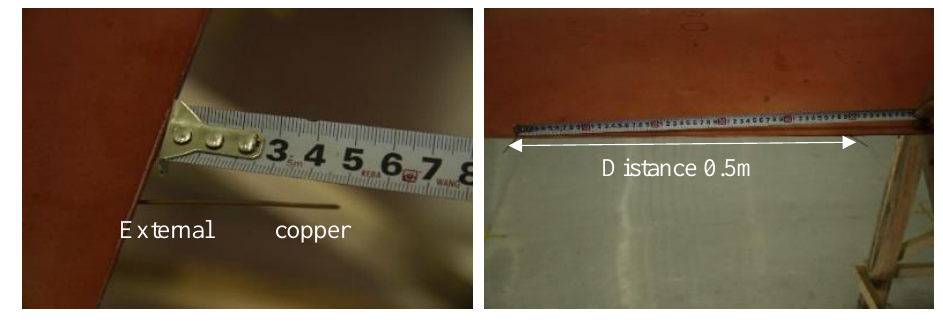
Figure 3. Experimental geometric